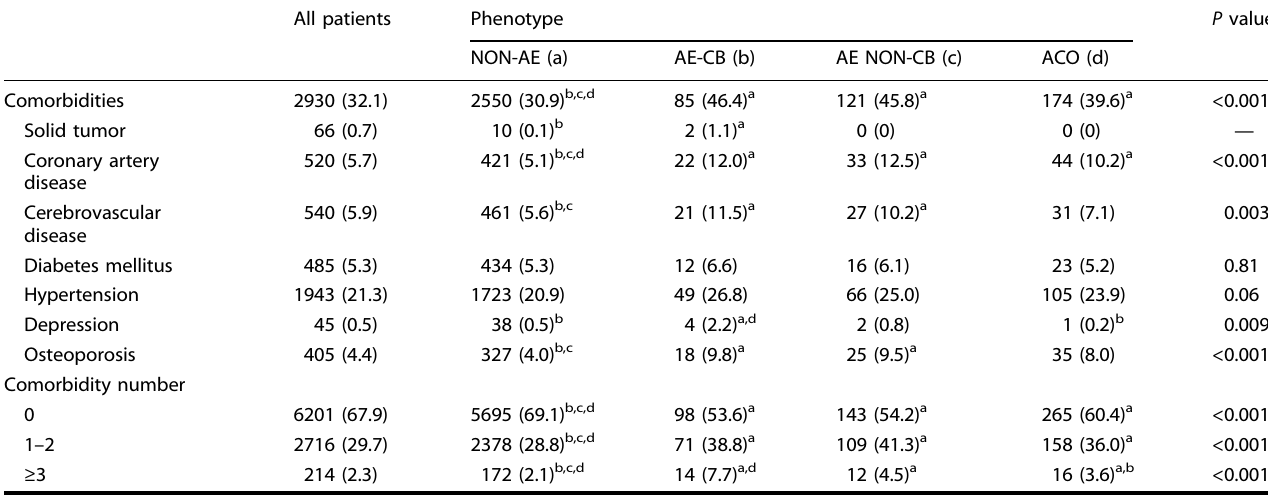
Table 2. Prevalence of comorbidities in patients with chronic obstructive pulmonary disease according to phenotype. All